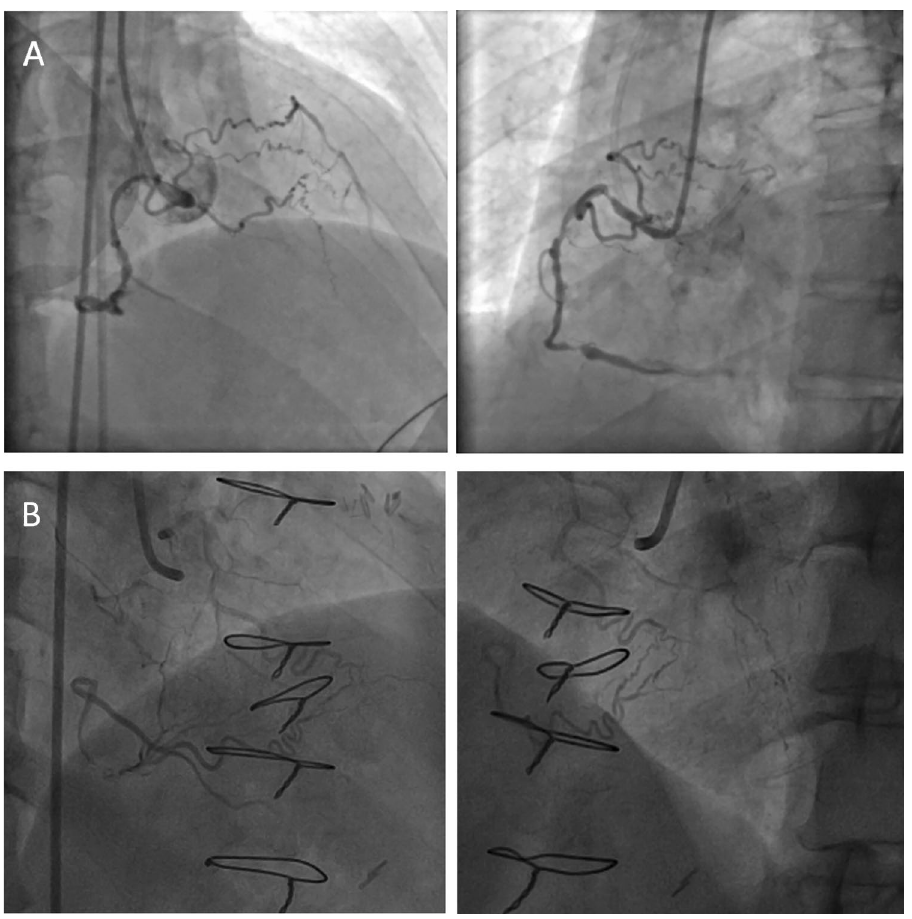
Figure 1. ( A ) Right anterior oblique and left anterior oblique projections of a conus branch artery collateral to left anterior descending artery. ( B ) Right anterior oblique projection of a conus branch artery collateral to distal RCA via a tortuous